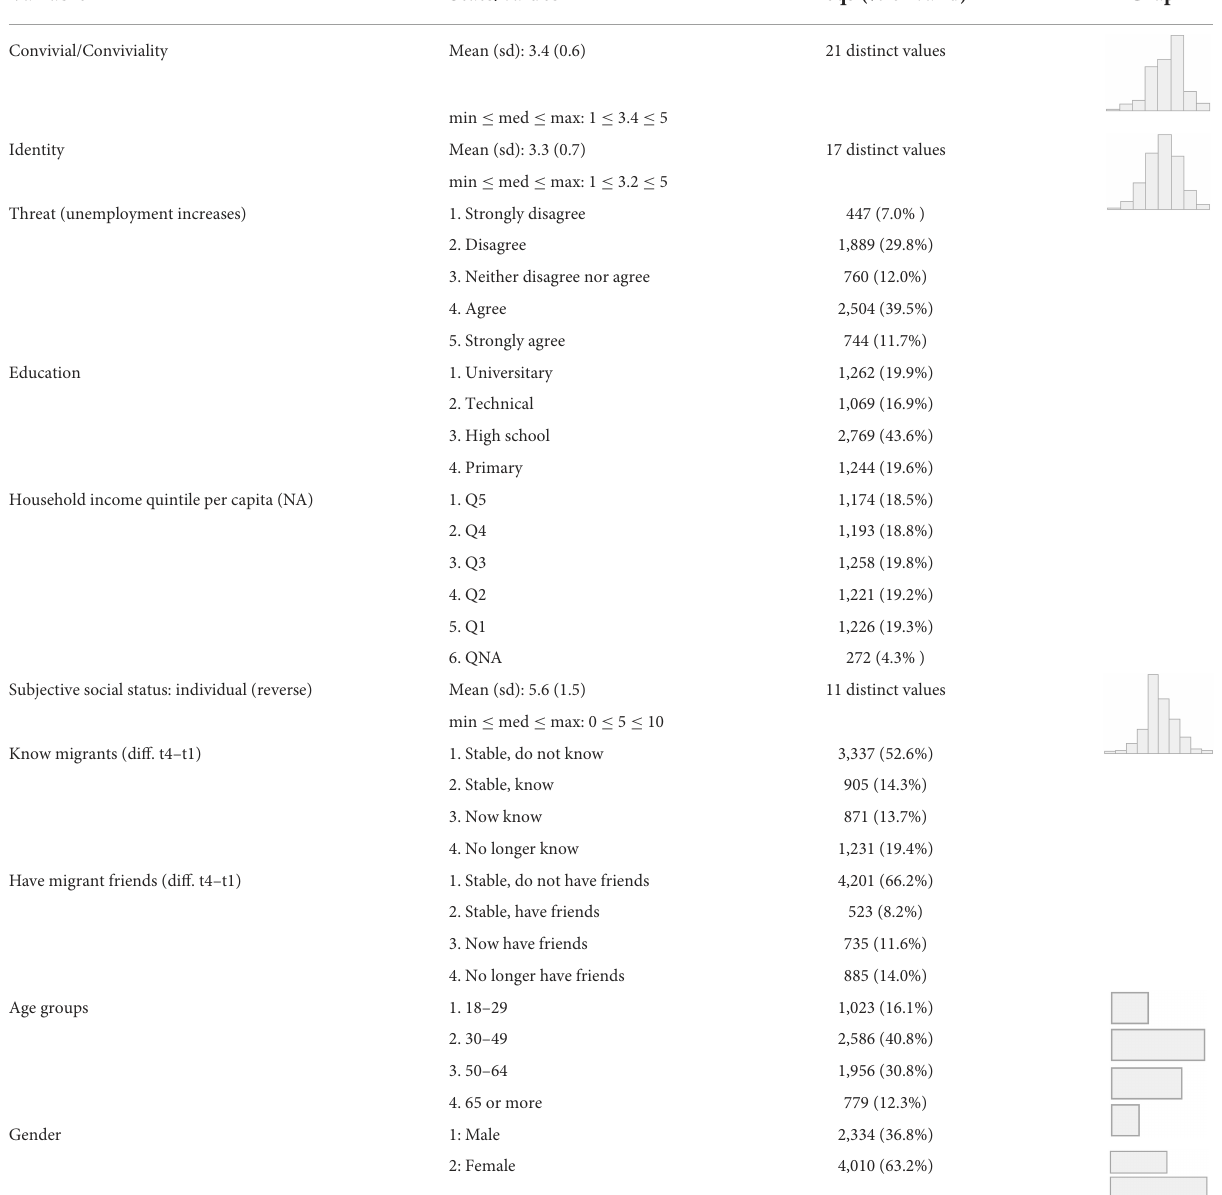
TABLE 3 Descriptive statistics of individual data. Variable Stats/values Freqs (% of valid)